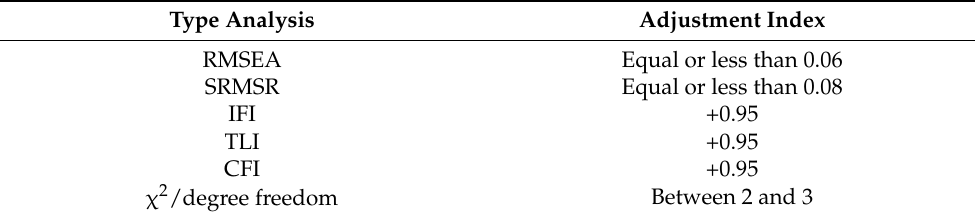
Table 1. Confirmatory factor analyses (CFA) adjustment